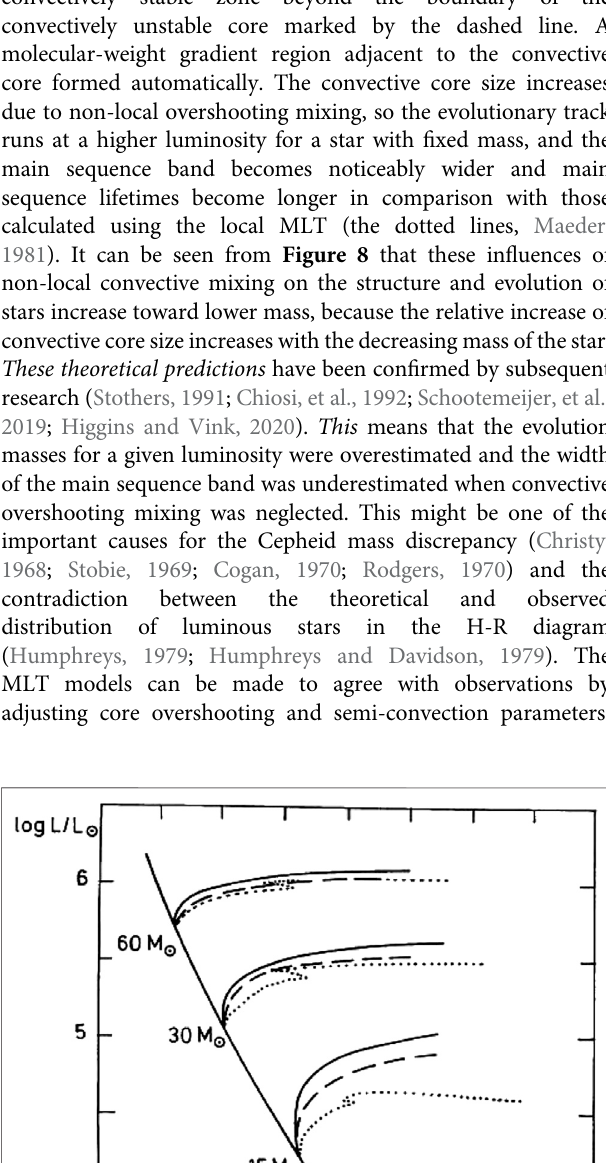
Frontiers in Astronomy and Space Sciences |